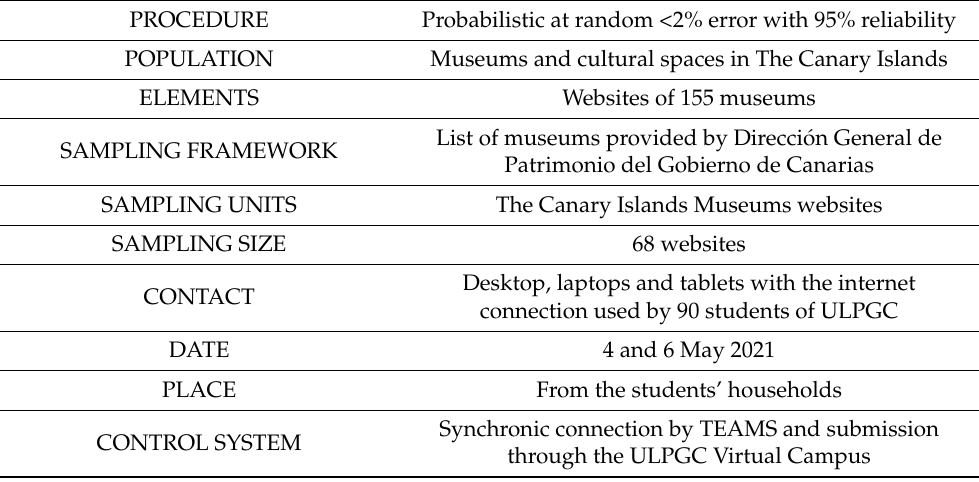
Table 3. The survey spreadsheet on The Canary Islands museums.